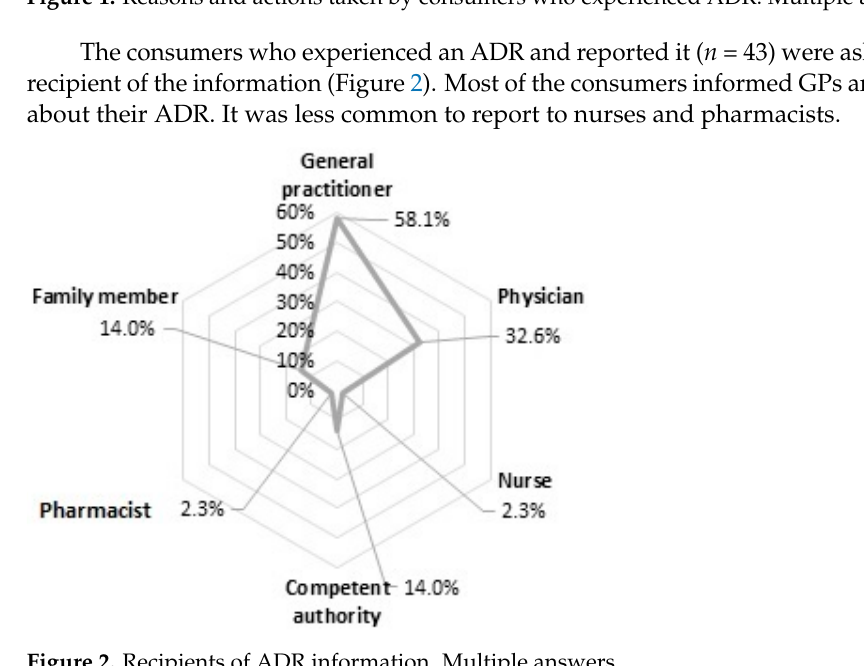
Figure 2. Recipients of ADR information. Multiple answers.